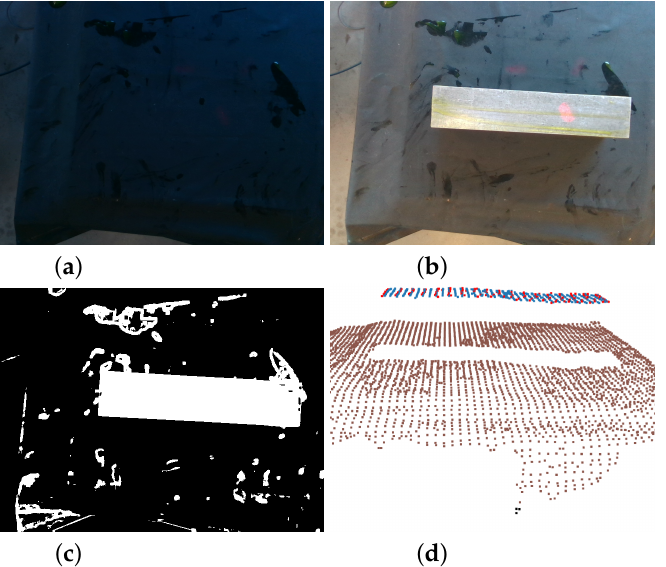
Figure 7. Structural-similarity based part localisation and path generation process for a calibration block with side-drilled holes. ( a ) Calibration image showing just the workcell. ( b ) Subsequent image with the part present. ( c ) Deducted image—kept pixels are shown in white, discarded pixels in black. ( d ) Resulting point cloud after remaining point clustering and selection. The identified part is in blue, extracted way-points in red.